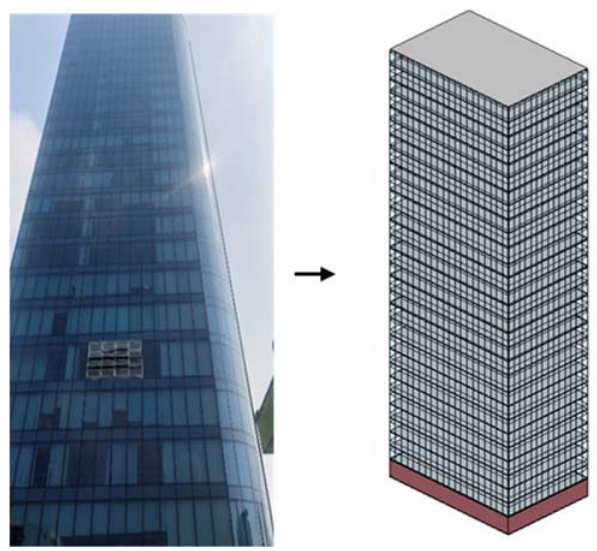
Figure 3. Building and simulation model.